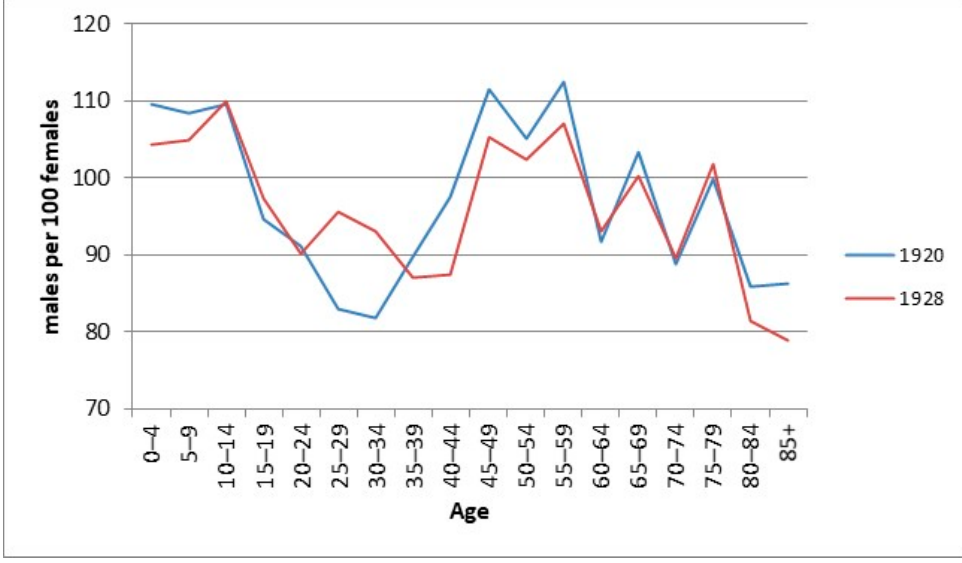
Figure 1. Sex ratio by age. Greece 1920–1928. Source: Greek census returns 1920, 1928.